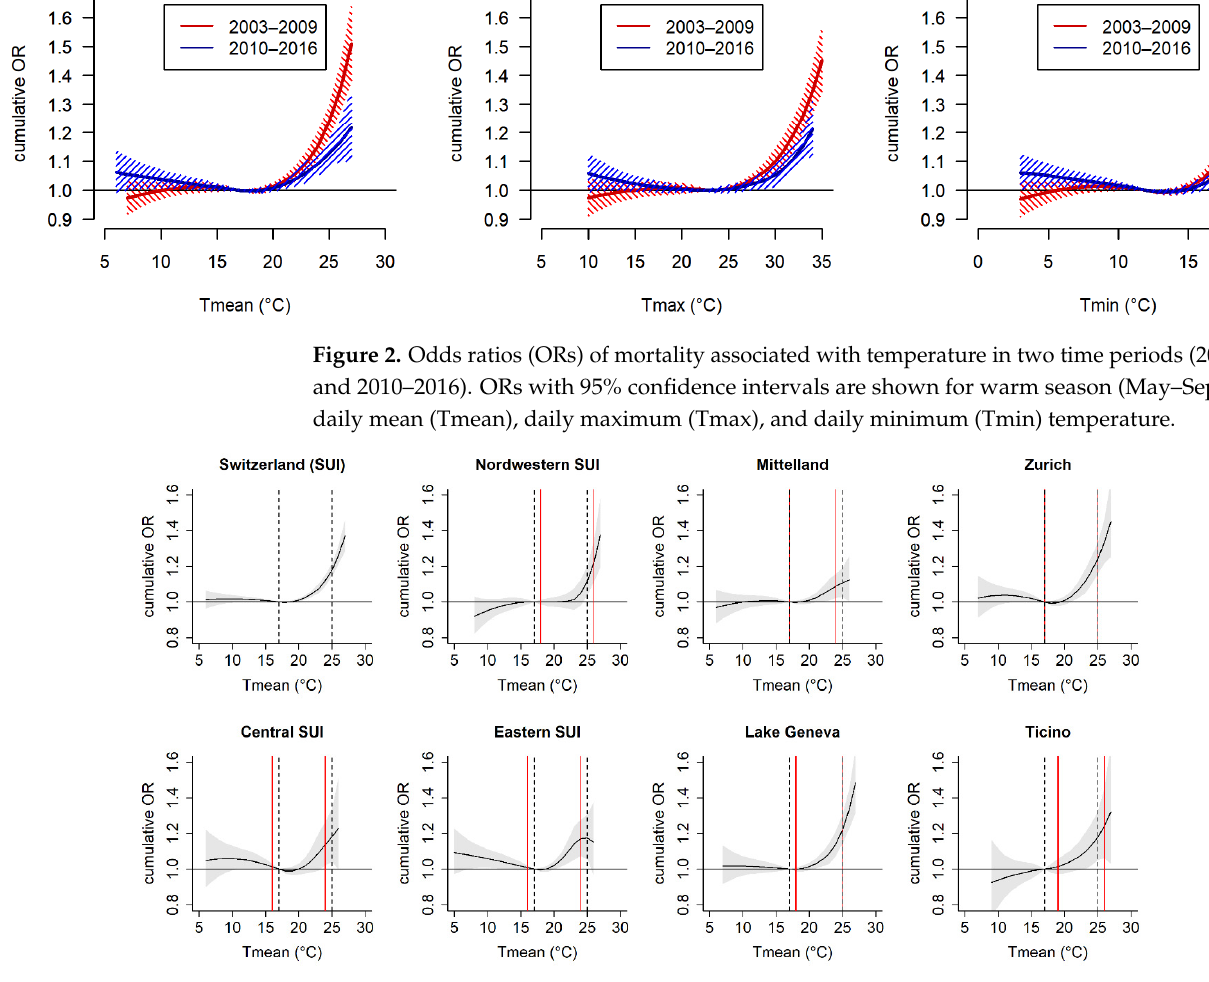
Figure 3. Region-specific odds ratios (ORs) of mortality associated with Tmean in Switzerland (May–September 2003 and 2016). Exposure–response associations are estimated based on the same (overall) model parameters and are reported for a cumulative 7-day lag versus the overall median of warm-season temperature across Switzerland. Vertical lines indicate the overall (grey dashed lines) and region-specific (red solid lines) 50th (median) and 98th